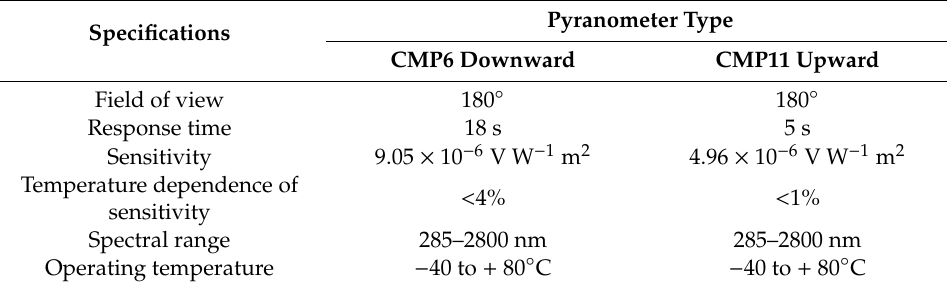
Table 2. Pyranometer sensor type, properties, and specifications.